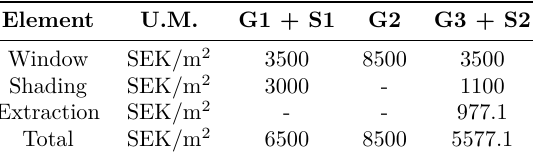
Table 2. Window and shading elements initial invest- ment